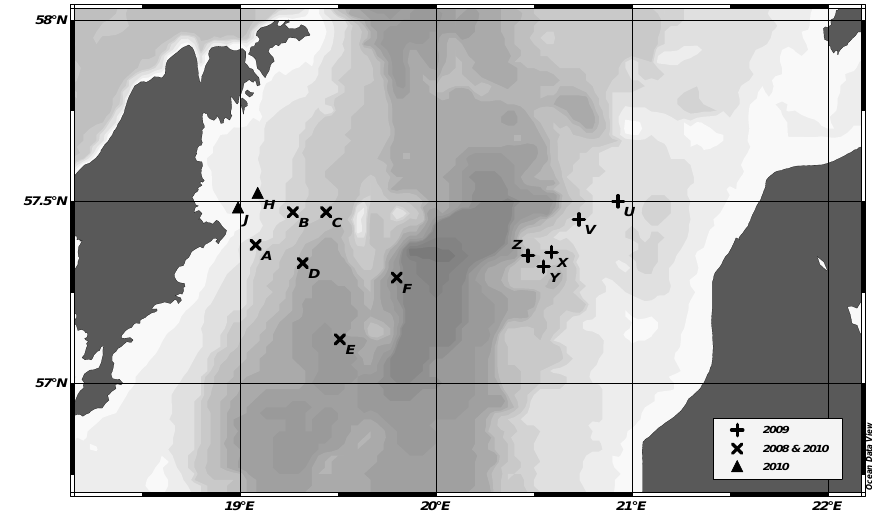
Fig. 1. Map of the central part of the Eastern Gotland Basin. Visited stations are indicated by a cross (2009 cruise), a triangle (2010 cruise only) and an x (2008 and 2010 cruises). Positions and water depths are given in Table